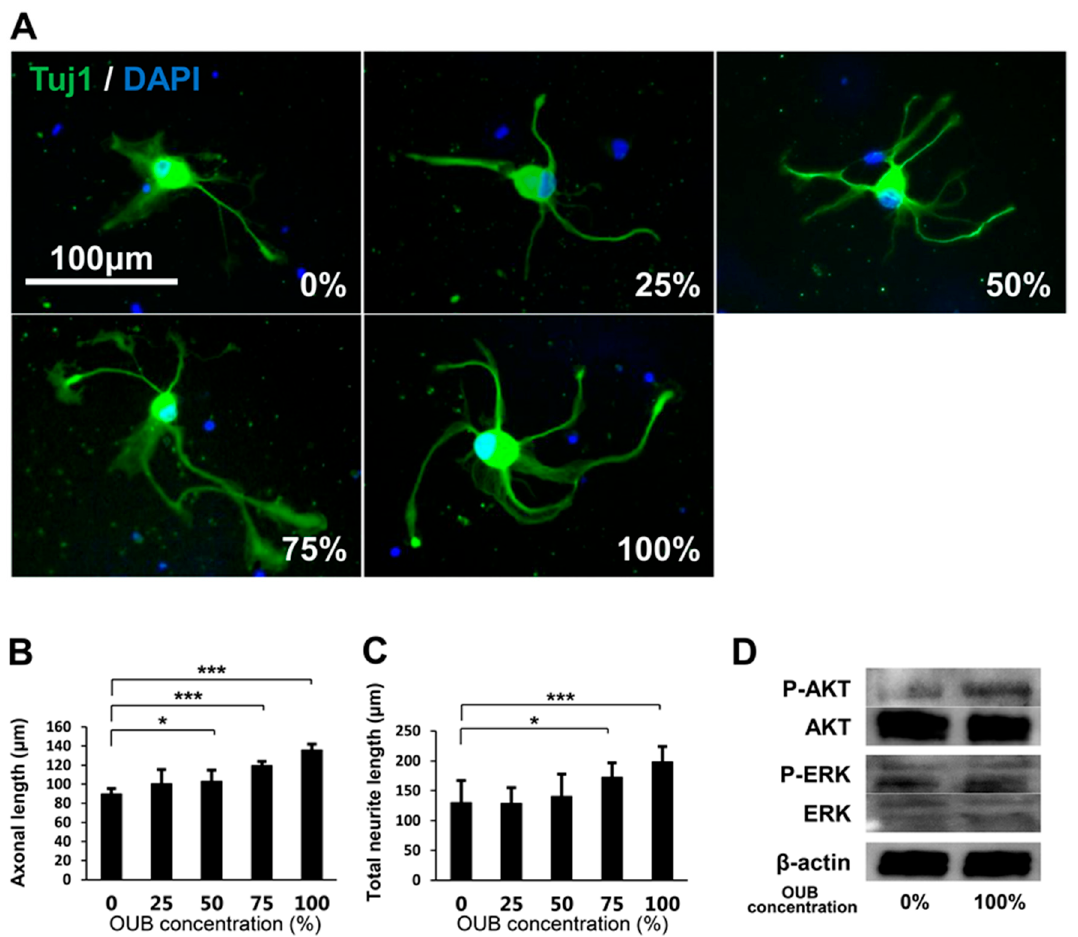
Figure 2. OUBs promote neurite outgrowth in DRG neurons. ( A ) Representative fluorescence micrographs of DRG neurons cultured for 48 h in OUBs diluted in Sato medium (concentration 0, 25, 50, 75, and 100%). Cells were co-stained with Tuj1 (green) together with DAPI (blue). Scale bar = 100 µ m. ( B , C ) Quantification of the axonal length (the length of the longest neurite per TuJ1-positive neuron) ( B ) and total neurite length per neuron ( C ). The axonal length and total neurite length were calculated from at least 30 neurons in each experiment; ( D ) western blotting of the neurite outgrowth related signals in cultured DRG neurons with or without OUBs. β -actin was used as an internal control. The data were analyzed by one-way ANOVA followed by Dunnett test. Graphs show mean ± SD. Results are representative of eight independent experiments. * p < 0.05, *** p < 0.001 compared with 0% group. OUBs: oxygen ultra-fine bubbles, DRG: dorsal root ganglion, Tuj1: neuronal class III β -tubulin, ERK: extracellular signal-regulated kinase.